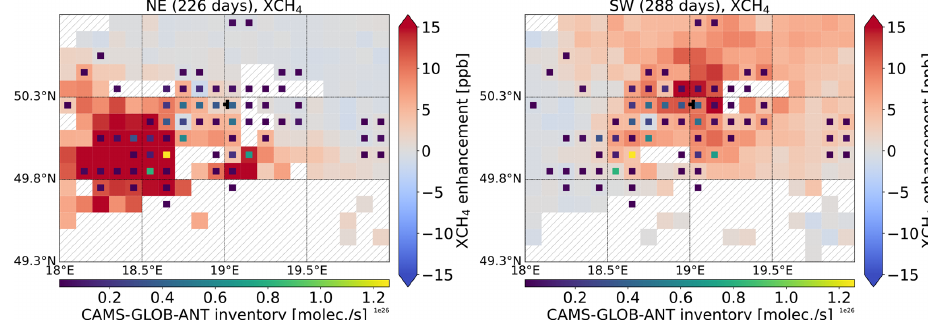
Figure A3. The enhancements for wind coming from NE and SW.